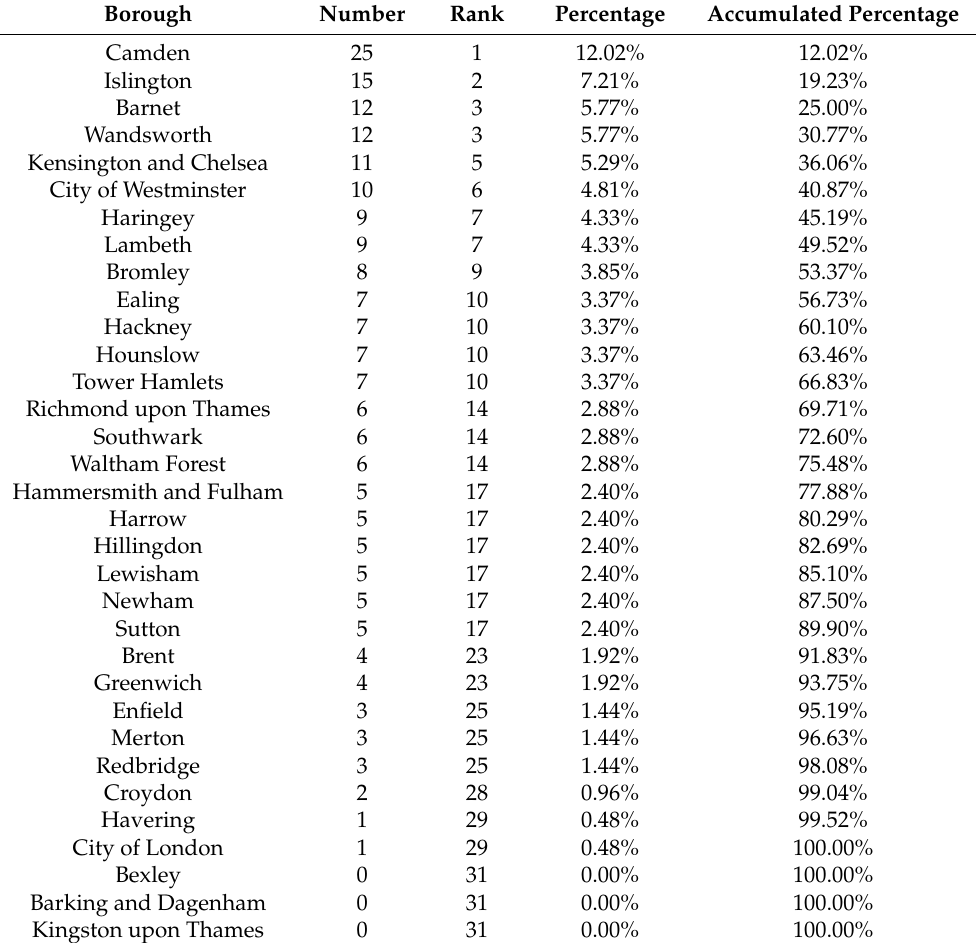
Table 1. Statistics on the Number of Taijiquan Organizations in the Boroughs of